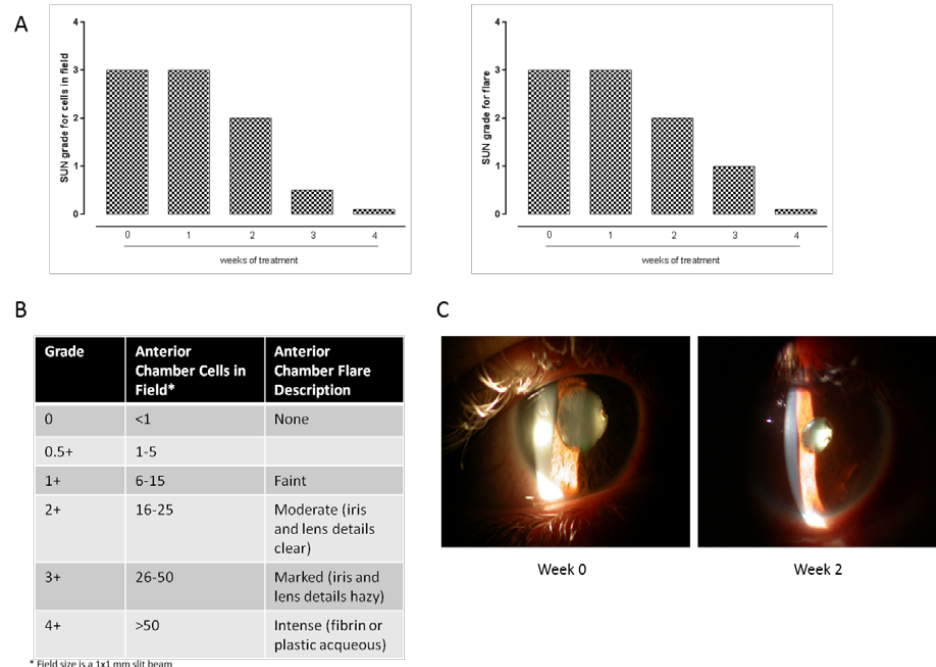
Figure 2. ( A , B ) Standardization of Uveitis Nomenclature (SUN) grading scheme attributed to the severity of uveitis during the 4 weeks of treatment with prednisone. The observations refer to the right eye and were made by a blinded ophthalmologist aware of the treatment; ( C ) Anterior segment